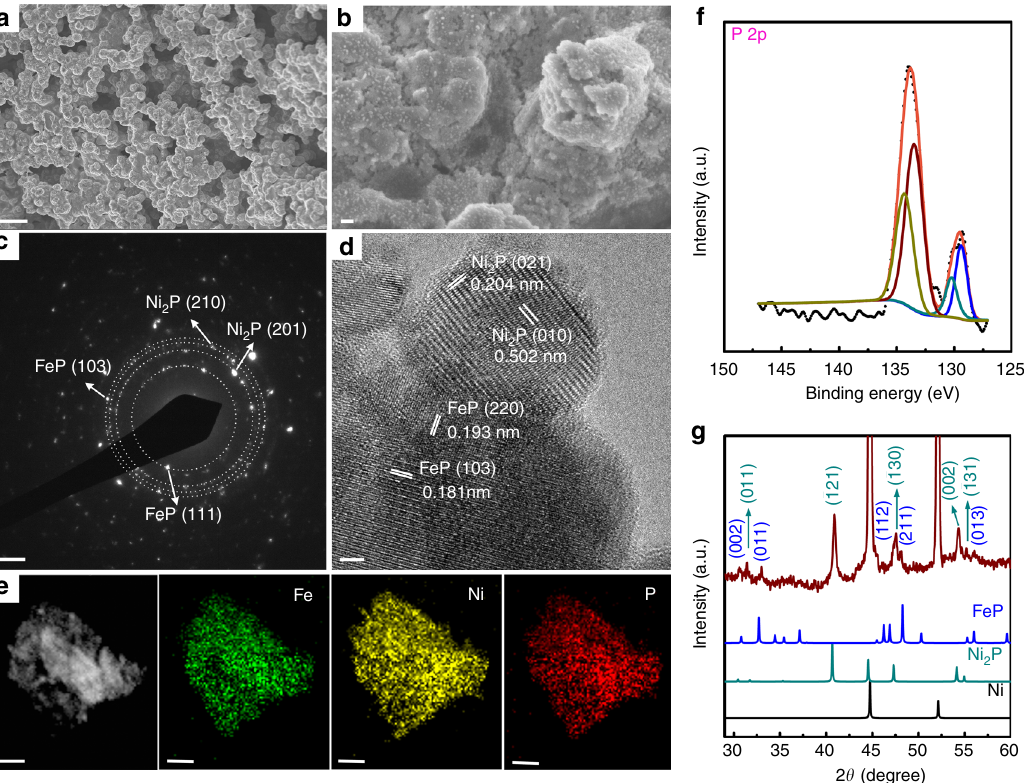
Fig. 1 Synthesis and microscopic characterization of as-prepared FeP/Ni 2 P hybrid. a Low-magni fi cation SEM images of FeP/Ni 2 P nanoparticles supported on Ni foam. Scale bar, 5 μ m. b High-magni fi cation SEM images of FeP/Ni 2 P nanoparticles supported on Ni foam. Scale bar, 200 nm. c The SAED pattern taken from the FeP/Ni 2 P catalysts. Scale bar, 2 1/nm. d A typical HRTEM image taken from the FeP/Ni 2 P catalysts. Scale bar, 2 nm. e The TEM image and corresponding EDX elemental mapping. Scale bar, 100 nm. f XPS analysis. g A typical XRD pattern of the samples (we did not show the full intensity of the peaks from Ni so that the peaks from the catalysts can be better